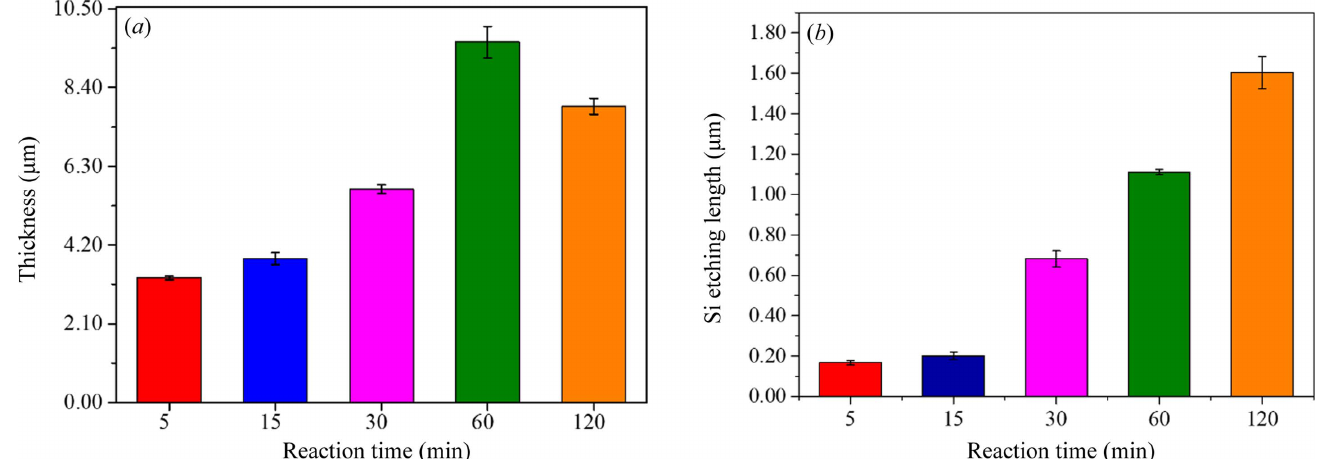
Figure 2 ( a ) Thickness of Ag-DNF layer and ( b ) Si etching depth for various synthesis